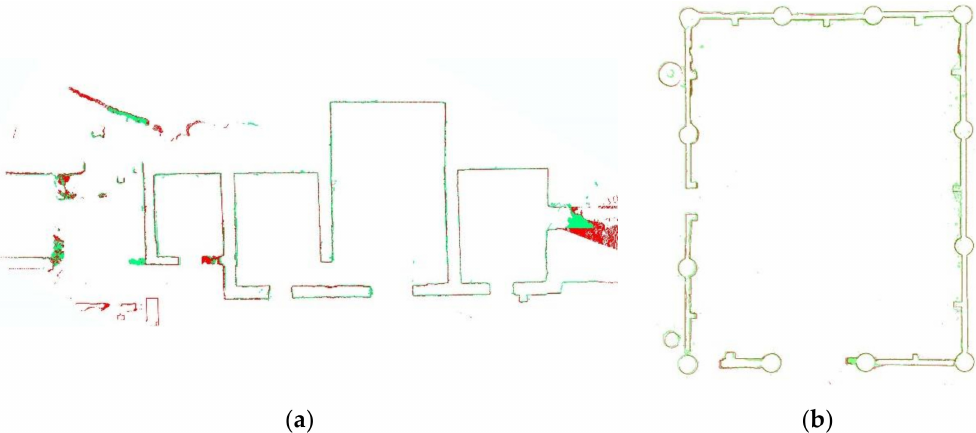
Figure 10. Overlapping cross sections generated in both point clouds, obtained using a horizontal plane at a height of 0.50 m above the ground. The result of the section of the cloud captured by the laser scanner appears in red, and that with the proposed system in green: Work zone 1 ( a ) at scale 1 / 235; and work zone 3 ( b ) at scale 1 / 180.